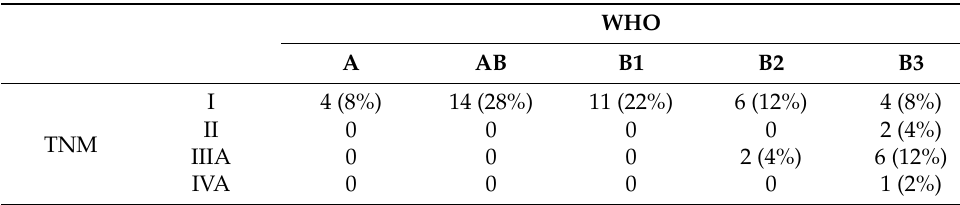
Table 3. TNM and WHO histological classifications.